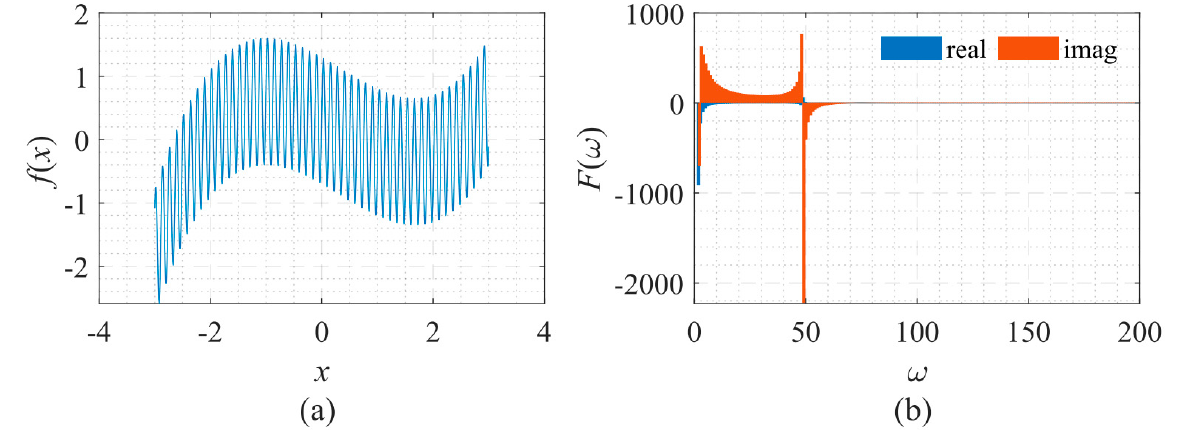
Figure 4. Signal described by Equation (10) with its frequency spectrum. ( a ) The function to be fitted. ( b ) The spectrum of the function.